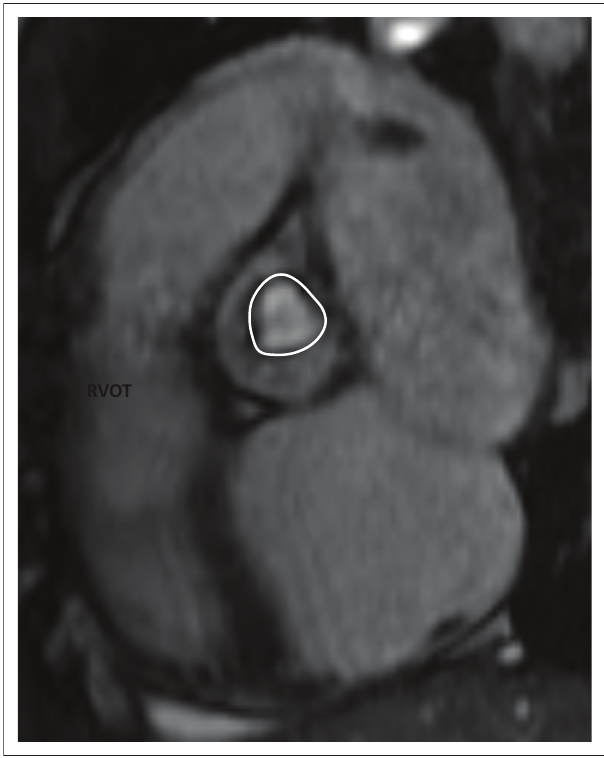
RVOT, right ventricular outflow tract. FIGURE 15: Axial cine SSFP image of the aortic valve demonstrates maximum opening of the valve traced (white line) to allow for surface area measurement.